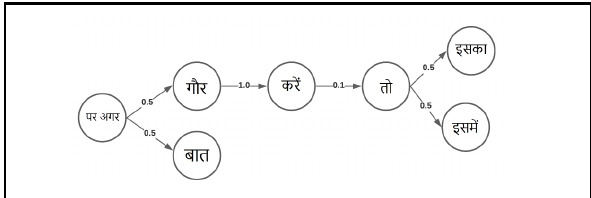
Fig 4.3 Sentence generation